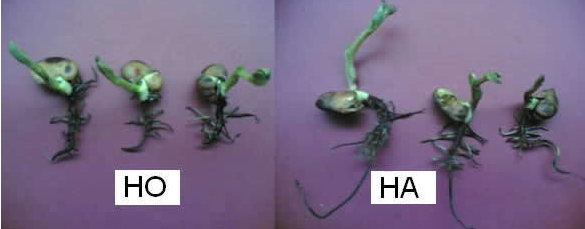
Fig. 1. Vicia faba L. seeds at the end of germination stage treated with HO: Hoagland and HA: Humic acid